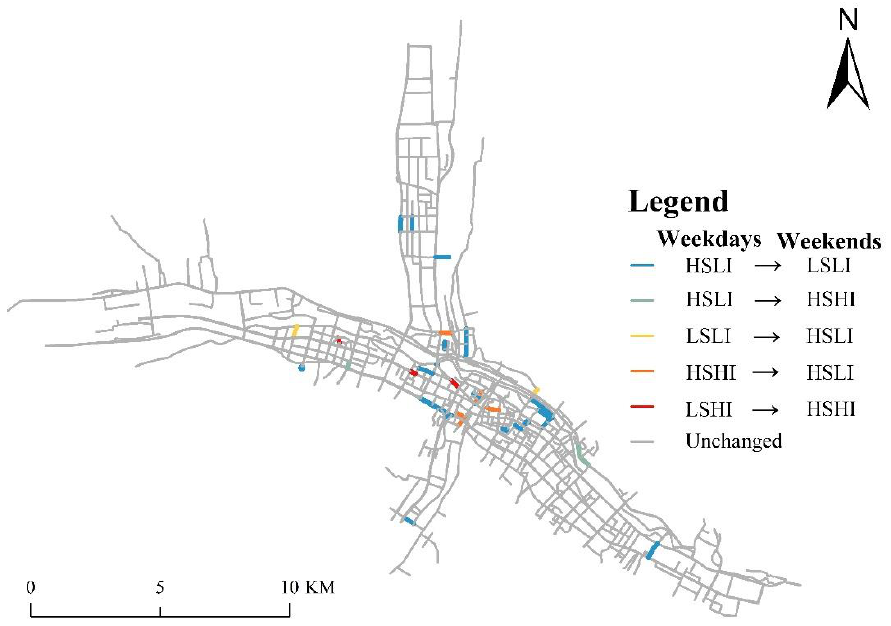
Figure 8. Spatial distribution of changes in street vitality types from weekdays to weekends.